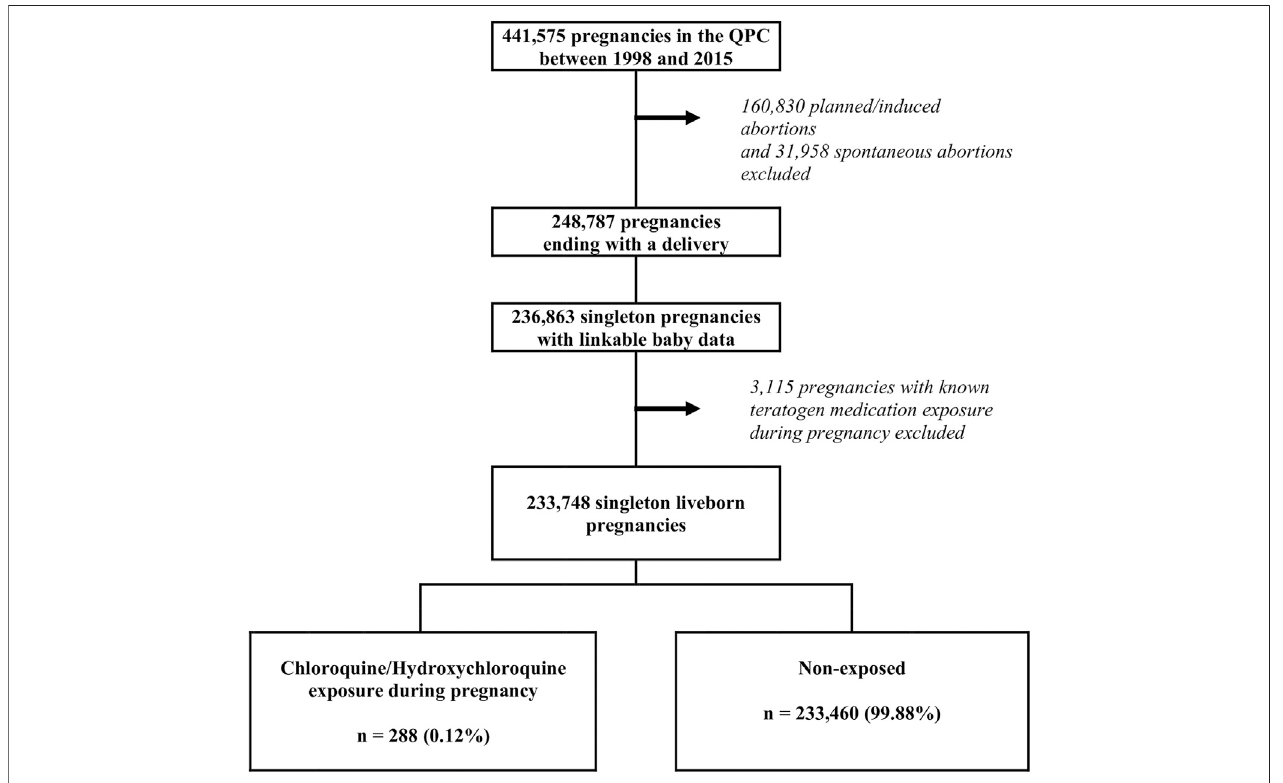
FIGURE 1 | Selection of the study cohort within the Quebec Pregnancy Cohort